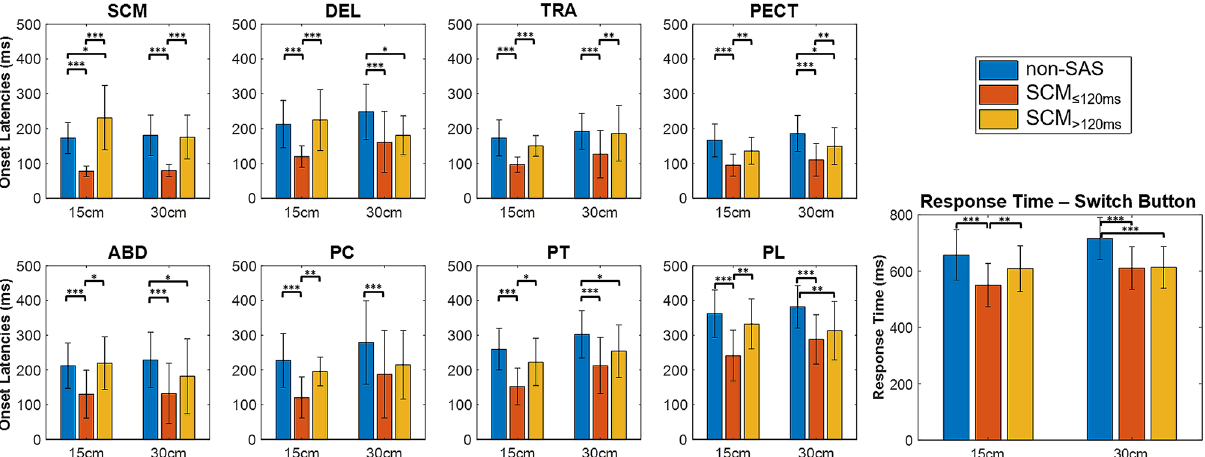
Figure 4. Barplots showing the response time (switch button) and onset latencies of the 8 muscles, in non-SAS trials (blue), and SAS trials with or without an early response in SCM (red: SCM ≤120 ms , yellow: SCM >120 ms ). Mean and standard deviation of the total values in the dataset are shown. Statistical significance levels for pairwise comparisons using Wilcoxon tests are shown: 0.05*, 0.01*, 0.001***. Only the SCM ≤120 ms trials show significant reductions in all the muscle onset latencies and the response